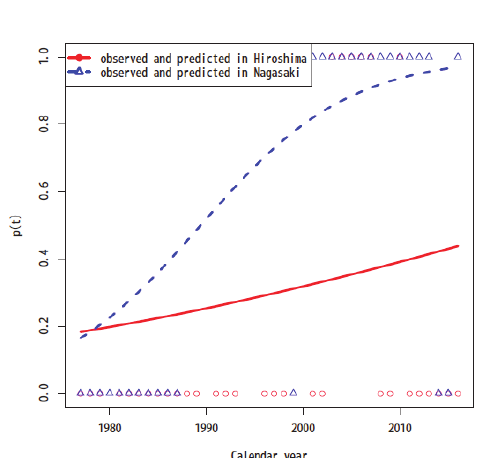
Fig. 18. Estimates and 95% simultaneous CI of regression coefficient in "law"